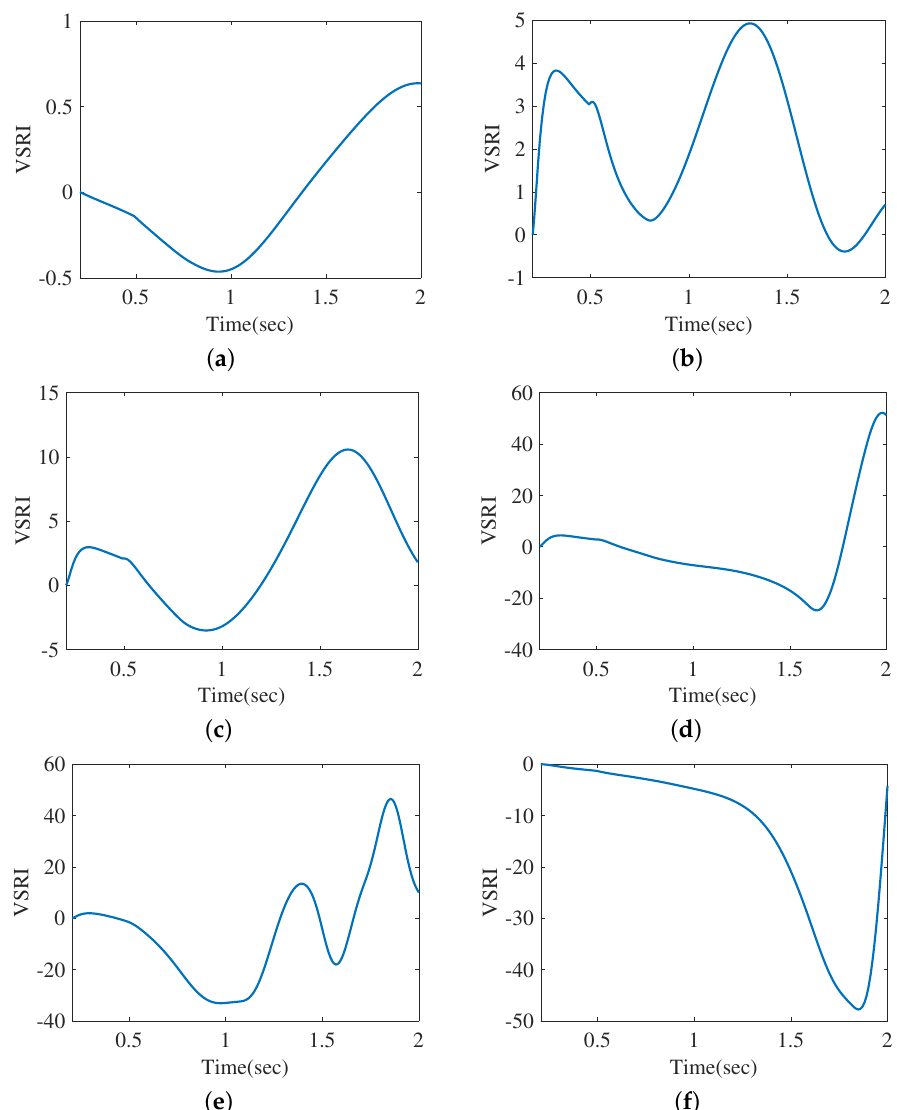
Figure 9. VSRI calculated for defined scenarios: ( a ) Case a, ( b ) Case b, ( c ) Case c, ( d ) Case d, ( e ) Case e, ( f ) Case